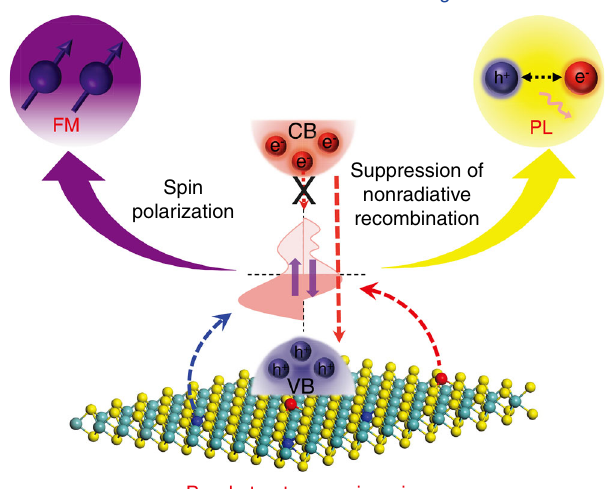
Fig. 1 Diagrammatic representation of the coexistence principle of photoluminescence and ferromagnetism. A possible way to bring the coexistent photoluminescence and ferromagnetism to monolayer TMDCs, through a band-structure engineering that retains the spin polarization of the impurity bands while suppresses the nonradiative recombination of